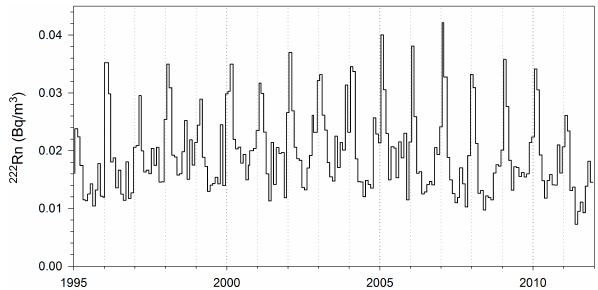
Fig. 3. 222 Rn activity time series based on monthly means.